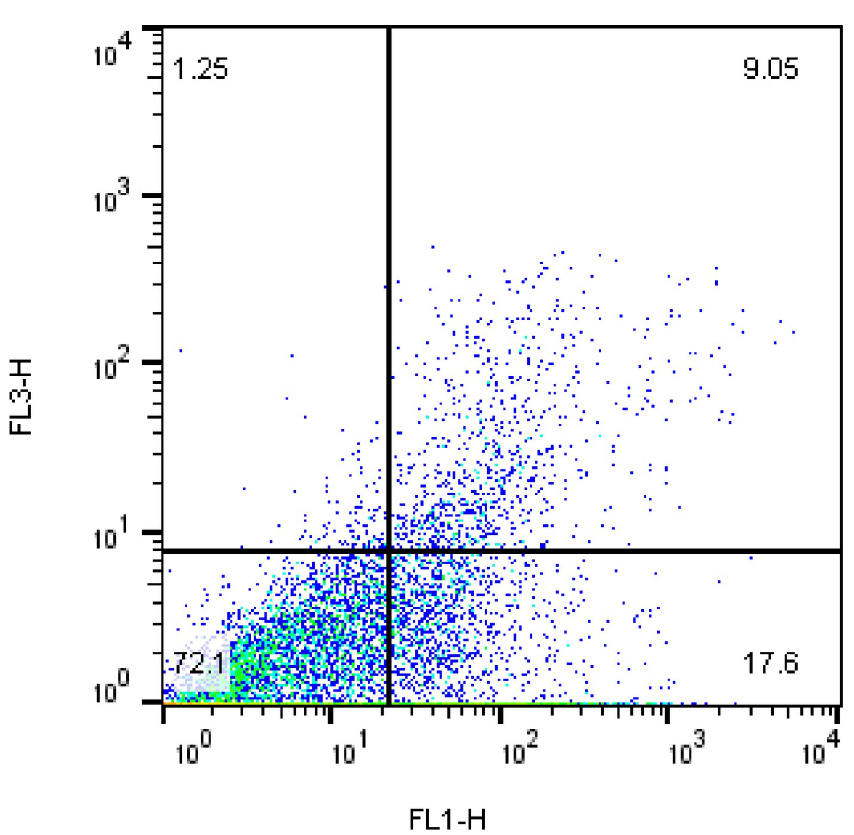
Fig 1. Annexin V (FL1-H) and propidium iodide (FL3-H) staining was used to determine the different cell populations. In each panel, the lower left quadrant shows Annexin-PI- cells (Viable spermatozoa), the lower right shows Annexin+PI- cells (early stage of apoptosis) and upper left and upper right show stained with PI (PI+) (dead